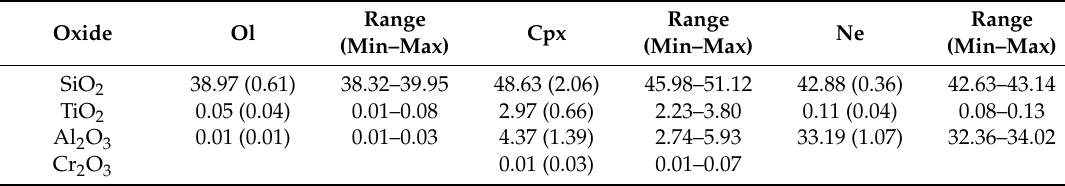
Table3. Averagecompositionofolivine(Ol), clinopyroxene(Cpx)andnepheline(Ne)inthemonchiquite sample. Standard deviation in